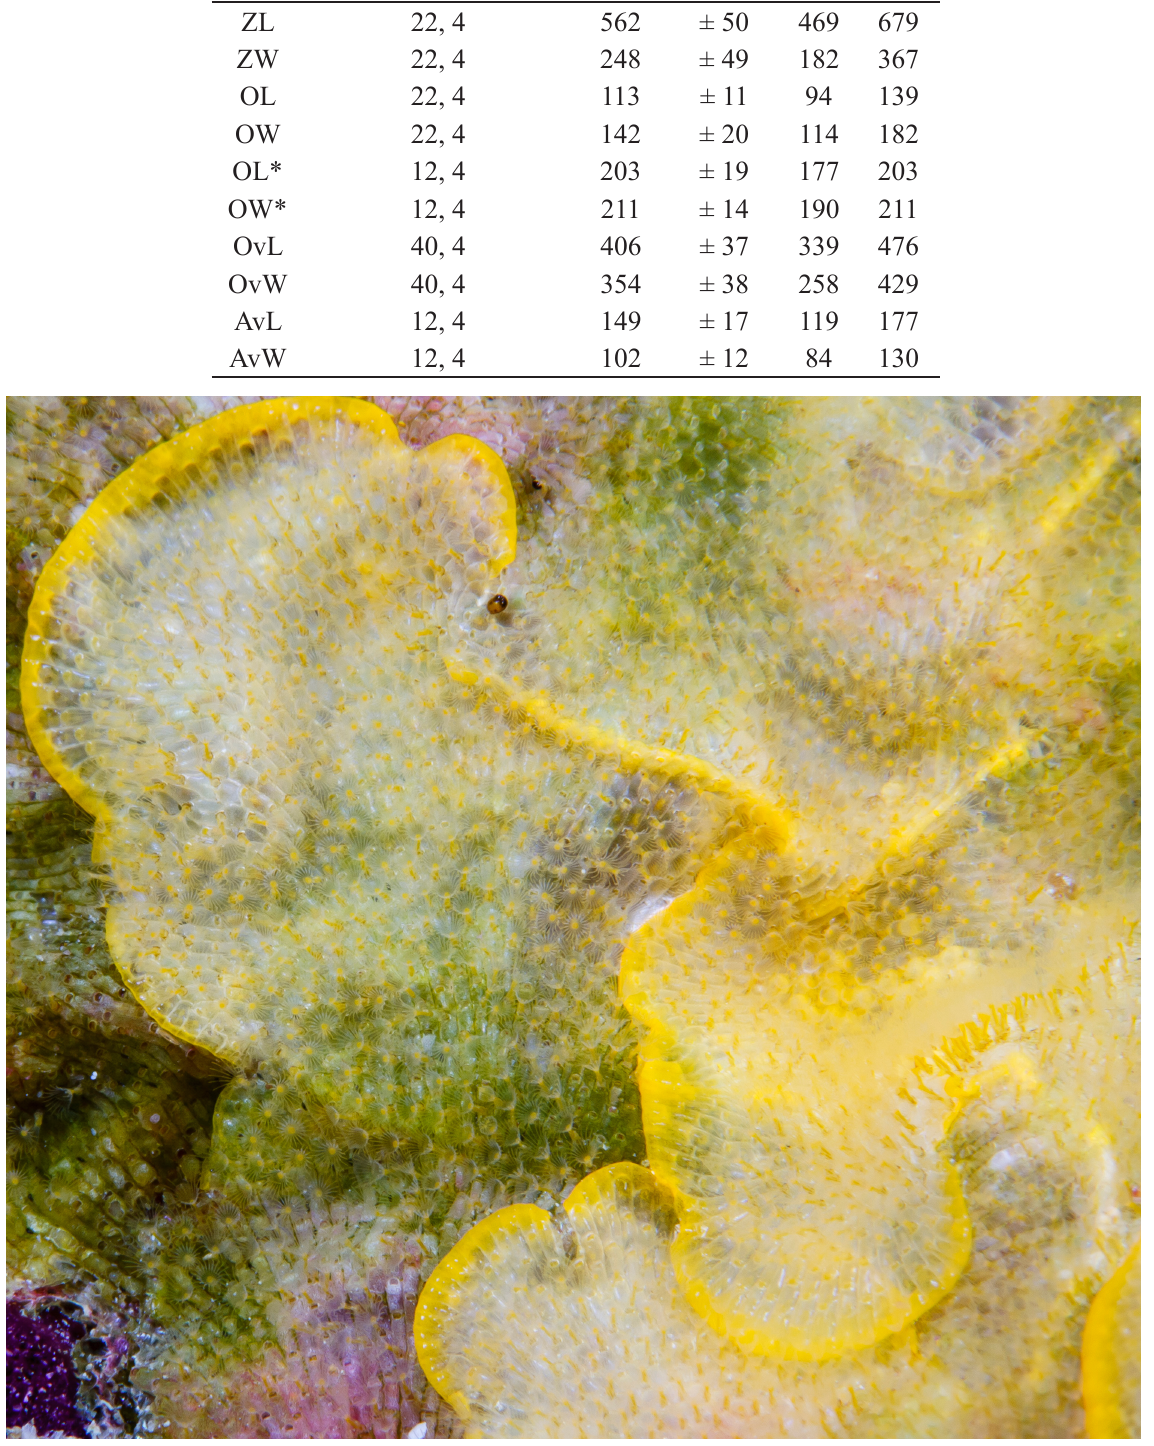
Table 3. Measurements in microns of Powellitheca waipukurensis (Waters, 1887) comb. nov.